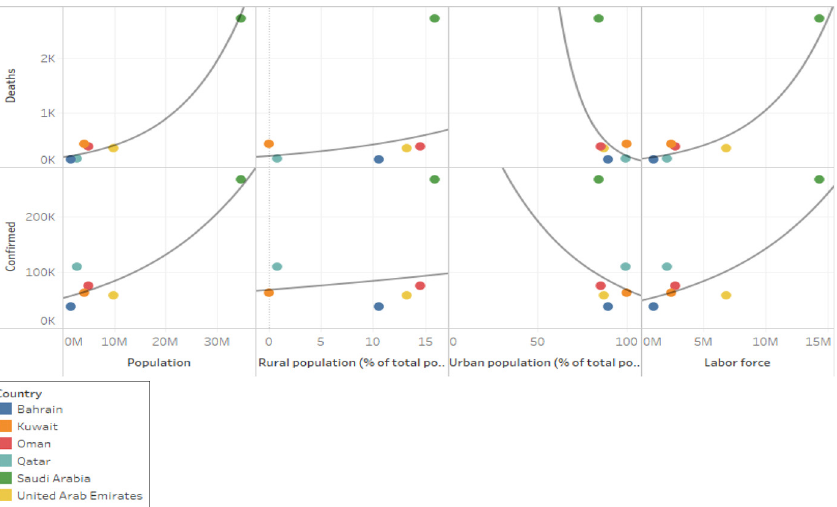
Figure 11. Con fi rmed cases and deaths vs